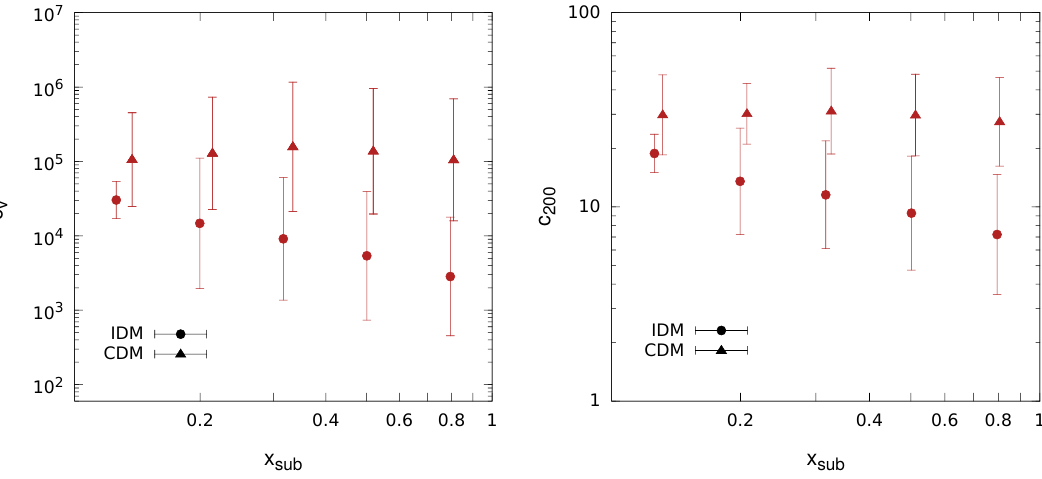
Figure 3. Median subhalo concentrations and 1 σ errors as a function of x sub , i.e., the distance to the centre of the host halo normalized to R 200 . We show results for c V (left) and c 200 (right) as derived from our set of LG